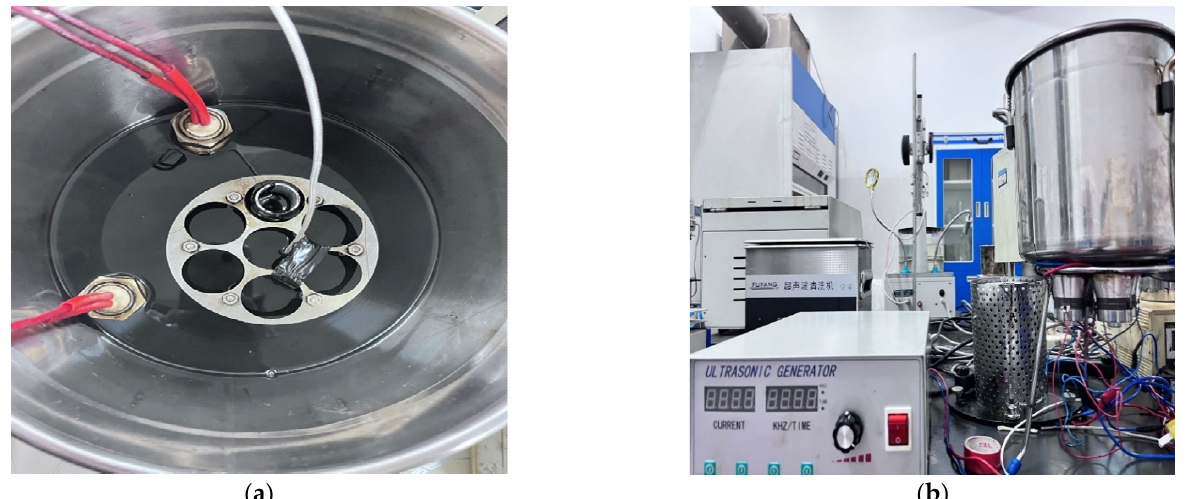
Figure 11. Self-made ultrasonic generator. ( a ) Top view ( b ) Main view